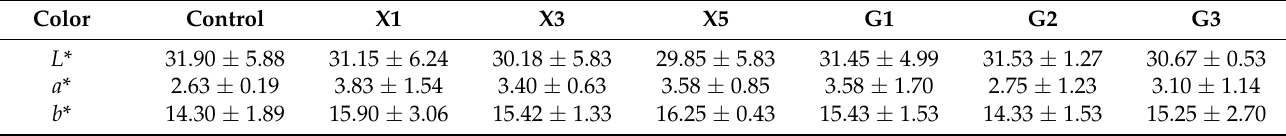
Table 4. Changes in the colors of soymilk-based banana-blueberry-puree by adding thickeners XanFlax and brand G.